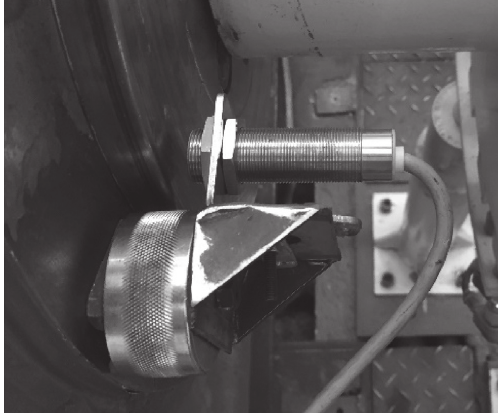
Figure 18: Axial movement